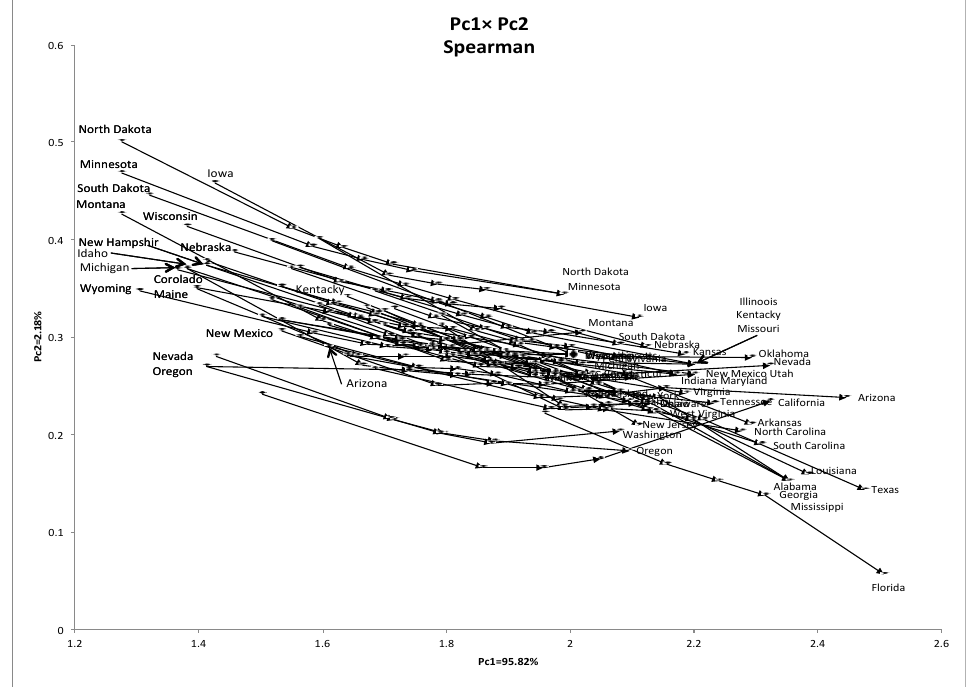
Figure 19. PCA result for US state weather data.